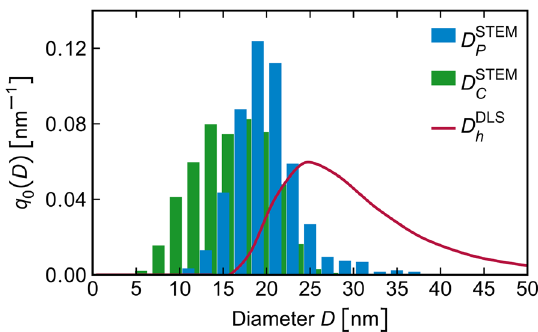
STEM D STEM C ) and the P ), their cores (